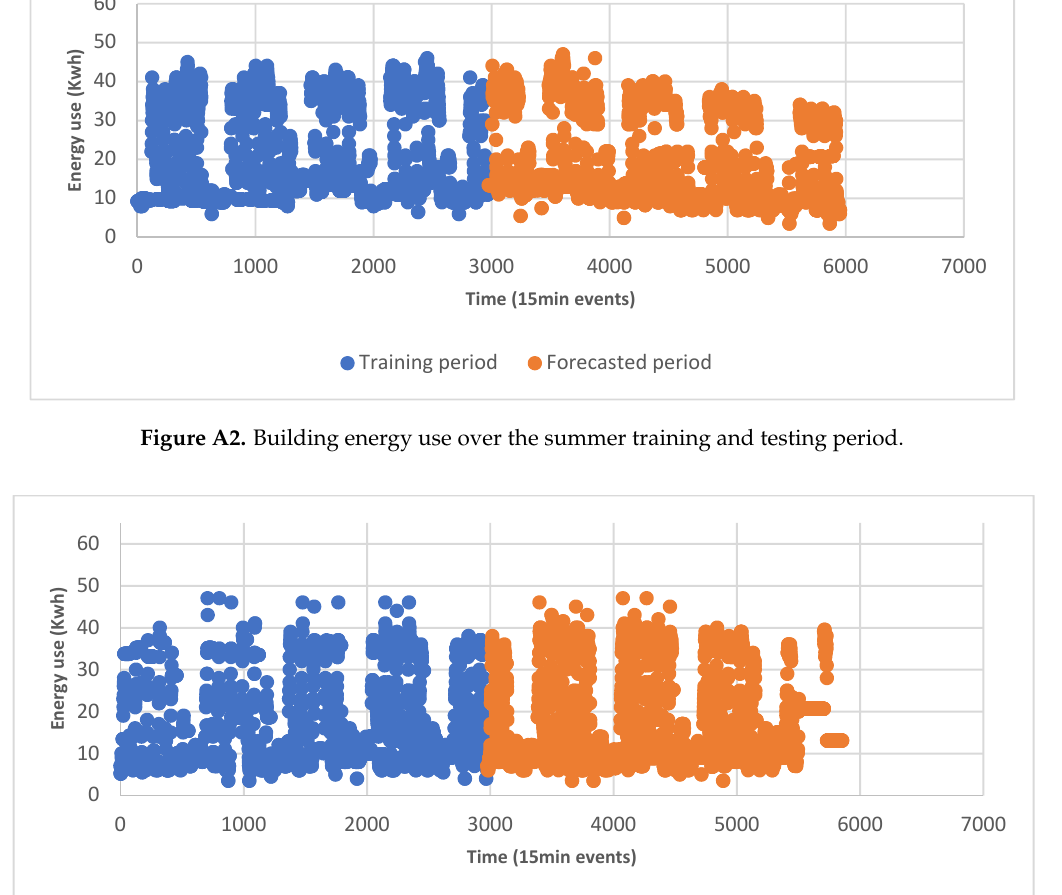
Figure A1. Building energy use over the spring training and testing period.